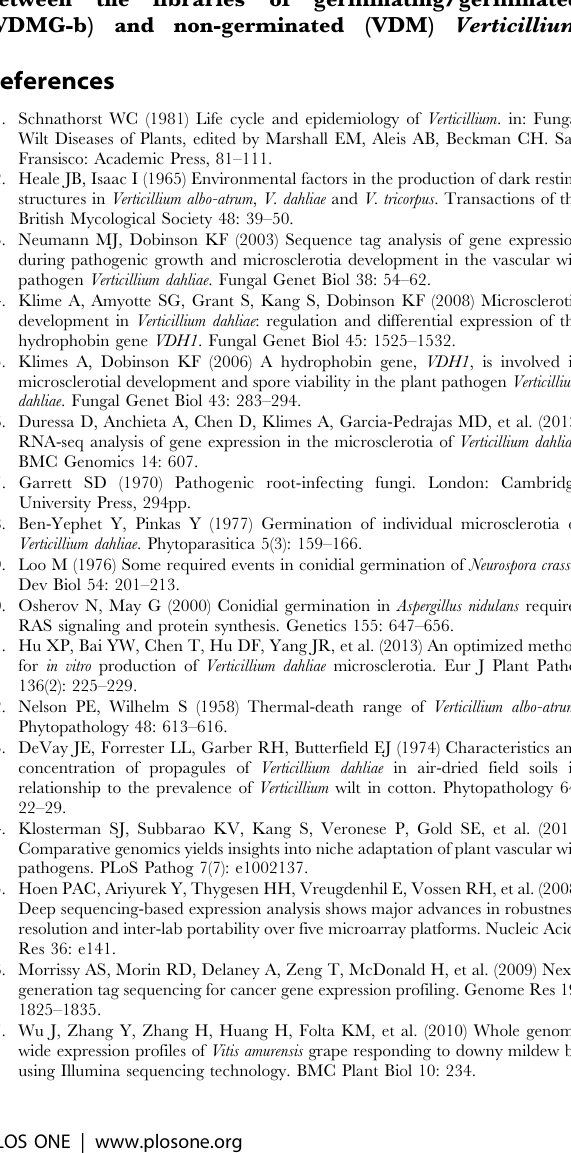
dahliae . Red and blue bars represent up- and down-regulated genes in VDMG-b compared to VDM, respectively. (TIF) Figure S4 Comparison of expression levels determined by qRT-PCR and RNA-seq for the randomly selected 20 genes in VDMG-b library compared to VDM library. (TIF) Table S1 Experimental parameters for RNA-seq analy- ses of Verticillium dahliae microsclerotia.